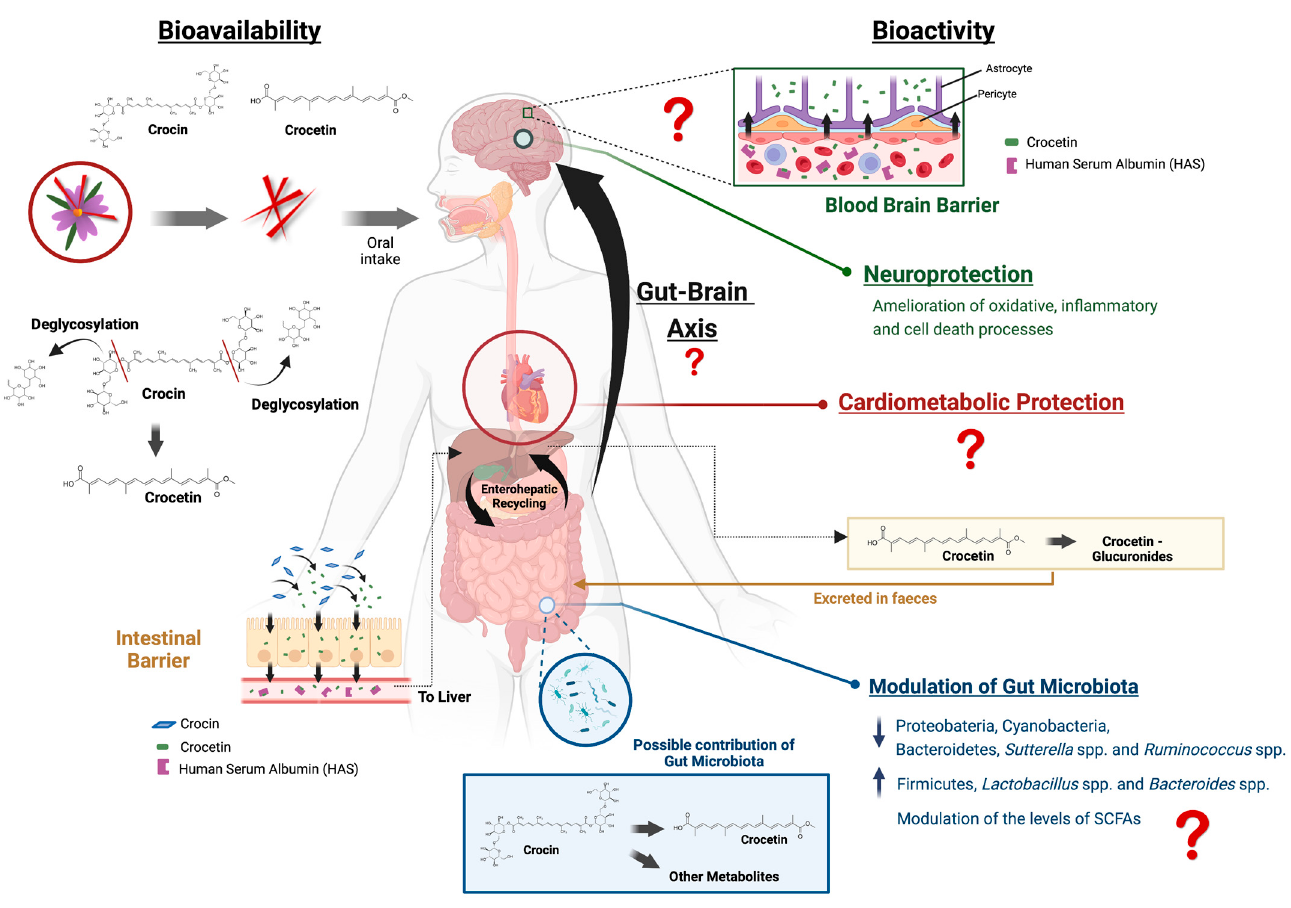
Figure 3. Summary of the current knowledge and hypotheses regarding the bioavailability and potential mechanisms of neuroprotection of saffron and its main bioactive compounds (created with BioRender.com accessed on 22 November).